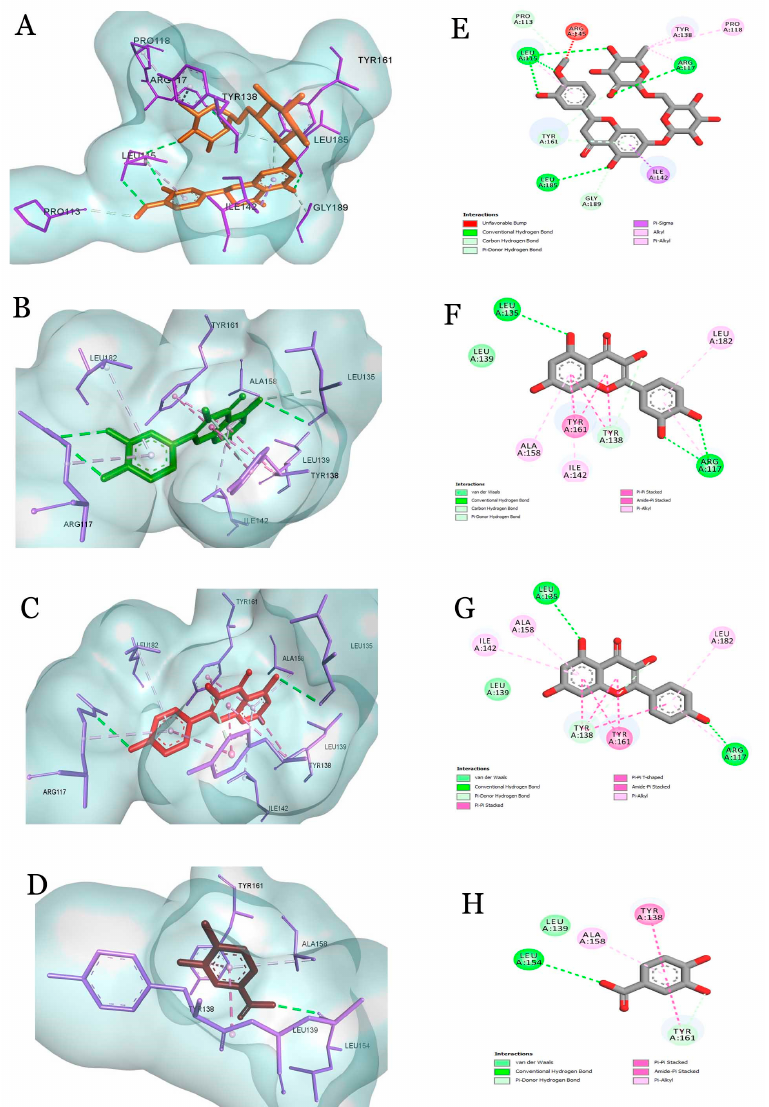
Figure 4. The interactions of the highest docking score ligands from different cultivars of kiwifruit and persimmon with HSA receptor protein. ( A ) hesperidin; ( B ) quercetin; ( C ) kaempferol; ( D ) protocatechuic acid (3,4-dihydroxybenzoic acid). 2D view of ligands and their bonding type are represented in ( E – H ).